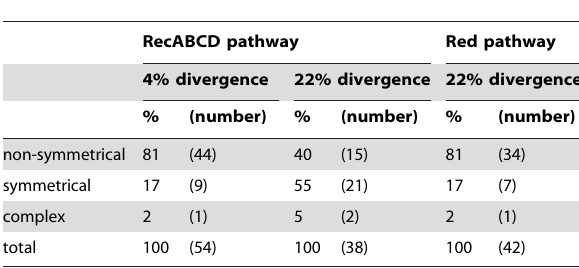
Table 2. Typology of the pairs of recombination products recovered for 4% and 22% diverged sequences from RecABCD- and Red-dependent